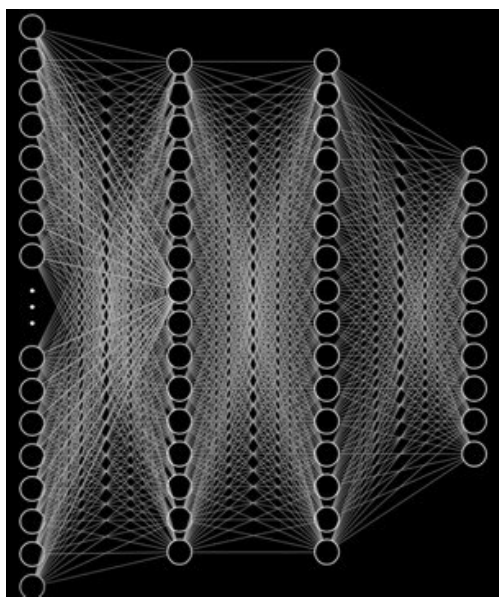
Figure 3. Generic